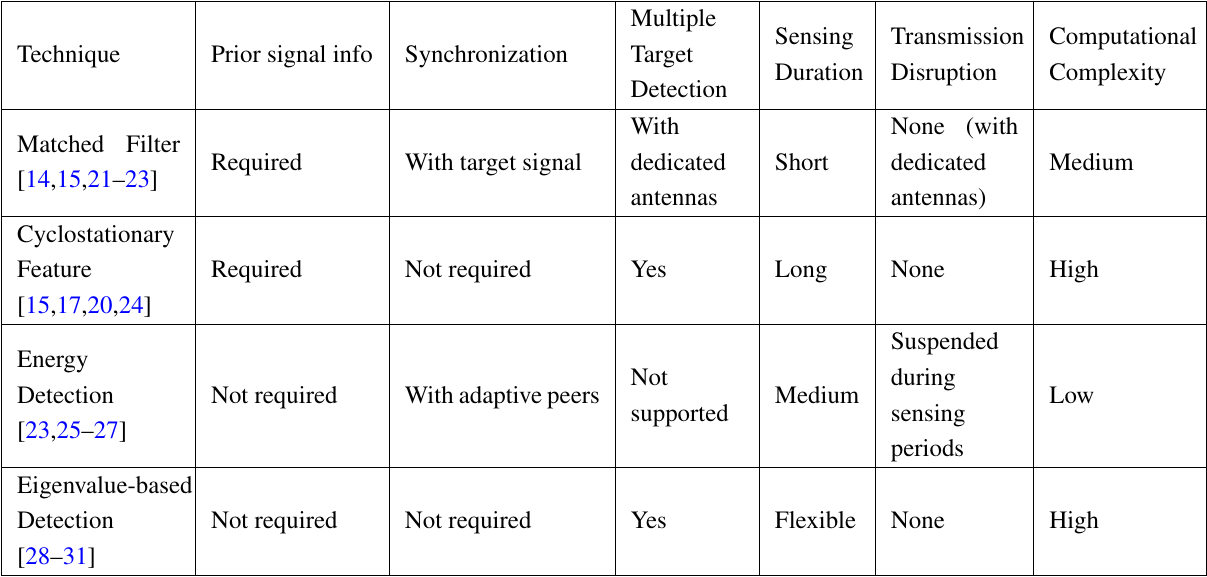
Table 1. A summary of main spectrum sensing